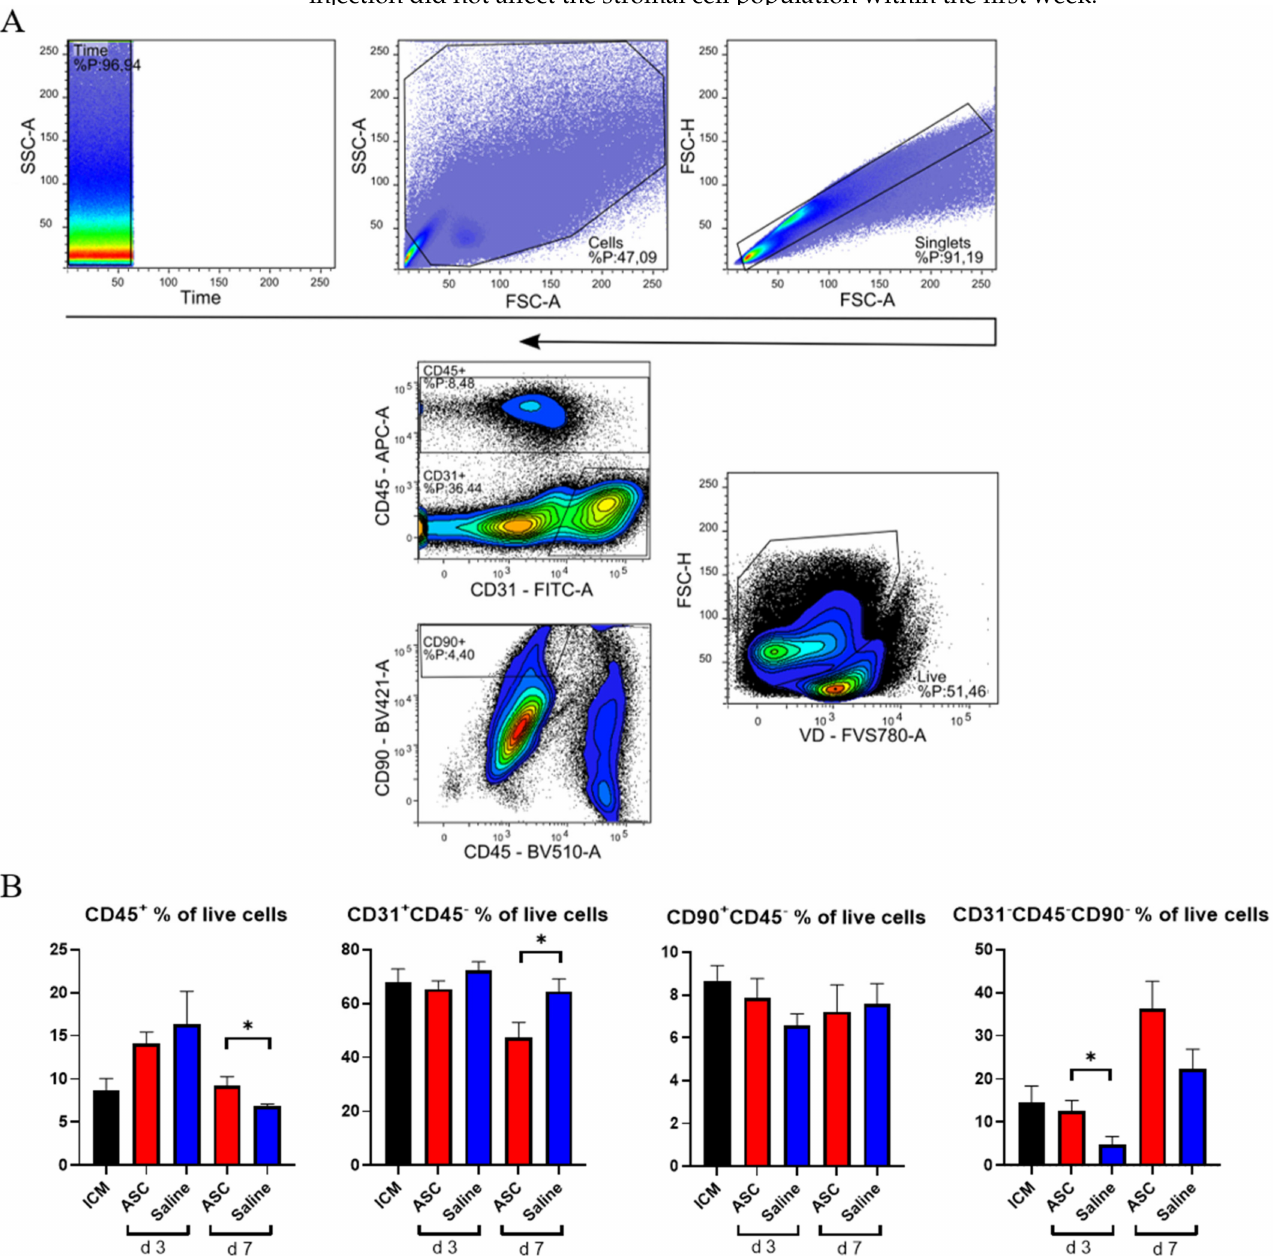
Figure 3. Analysis of cardiac cell composition. ( A ) Gating strategy for the cardiac composition for CD31, CD45, and CD90 across panels. ( B ) Cardiac composition results are depicted for CD45 + cells, CD31 + CD45 − cells, CD90 + CD45 − , and an uncharacterized population of CD31 − CD45 − CD90 − . ICM n = 5, ASC day 3 n = 6, saline day 3 n = 6, ASC day 7 n = 5, and saline day 7 n = 5. ICM; ischemic cardiomyopathy. * p <